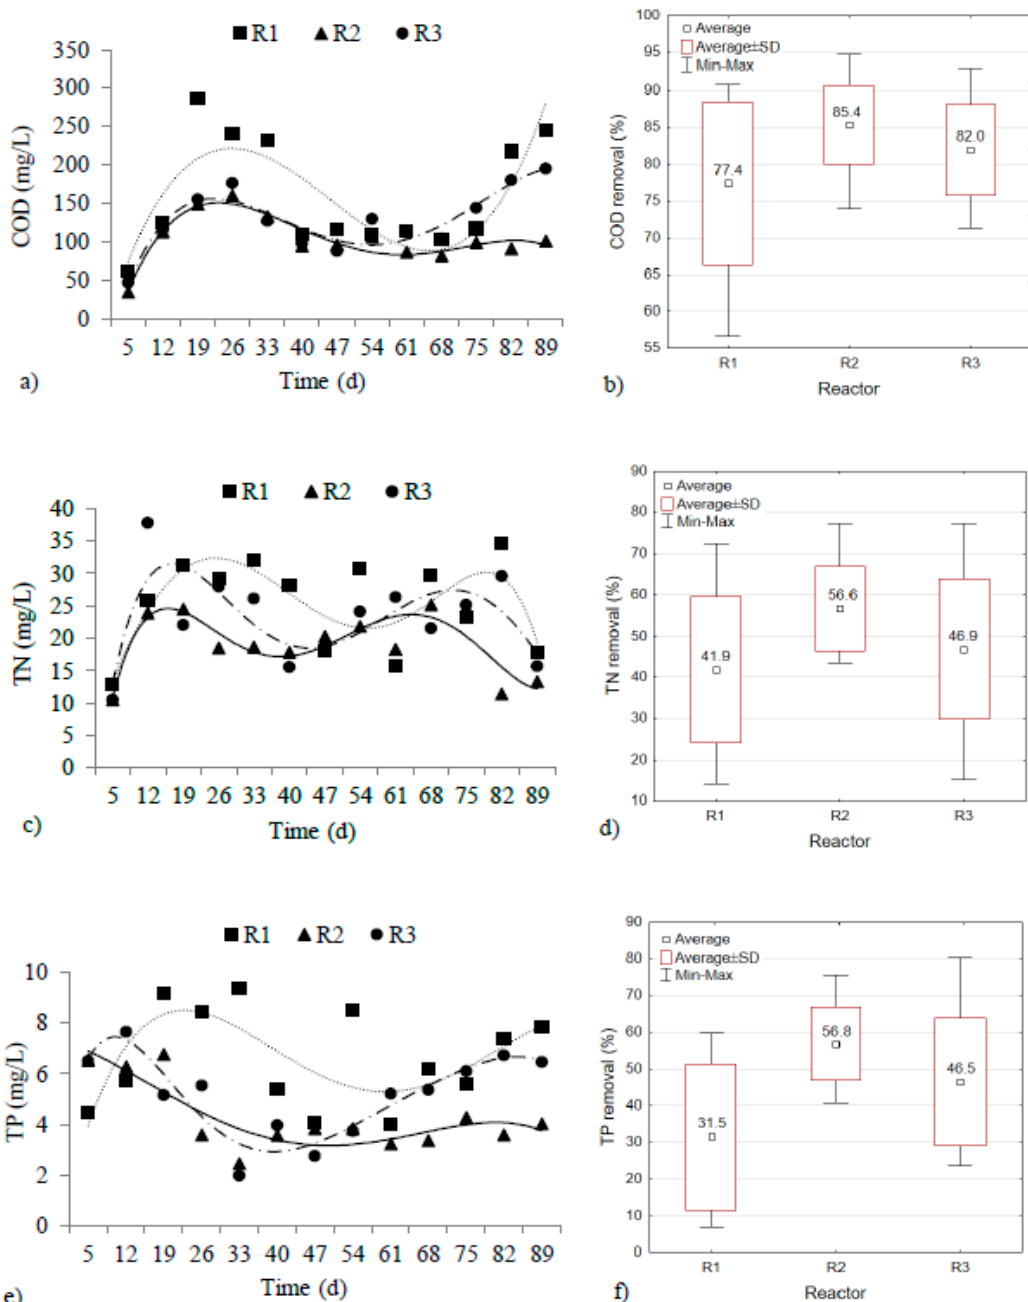
Figure 6. Reactor performance: changes in COD ( a ), TN ( c ), TP ( e ) in effluent and average values of COD ( b ), TN ( d ), and TP ( f ) removal.